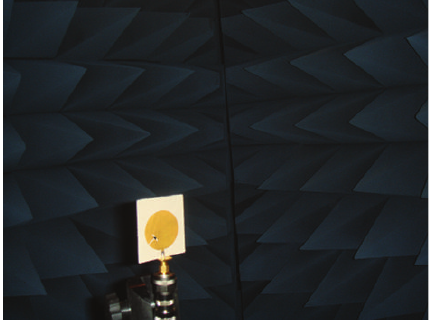
Figure 3: Antenna measurement in the anechoic chamber.